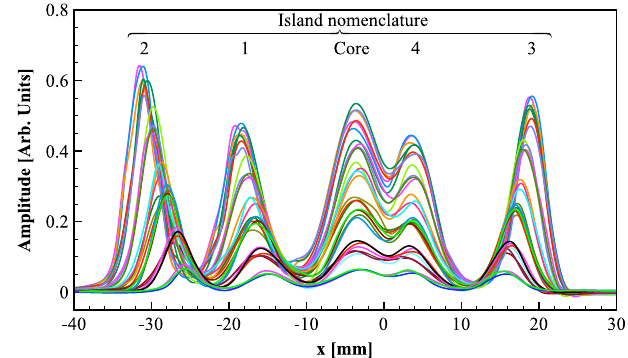
FIG. 7. Superposition of the horizontal beam profiles measured after splitting for various beam intensities. The displacement of the four outermost beamlets due to the change in the total beam intensity is clearly visible. The raw data are fitted here with splines to improve the visibility of the different profiles. The results shown in Figs. 9 and 11 have been obtained by fitting the raw data with the function of Eq. (6).